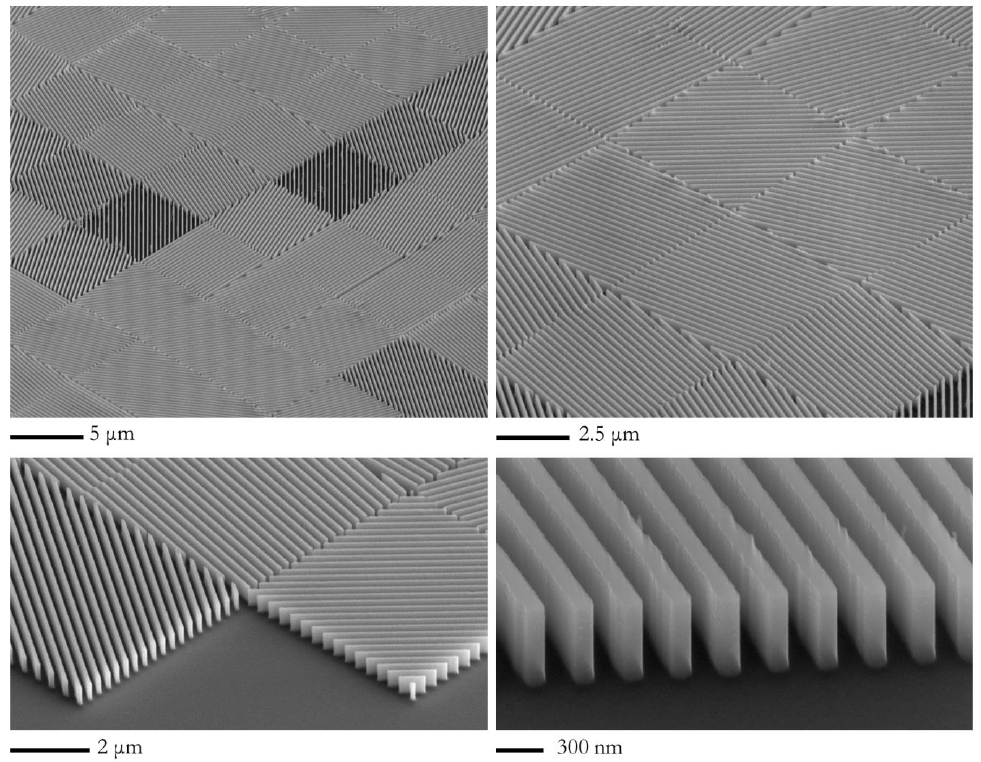
Figure 4. SEM inspections of the fabricated PBOE on a silicon substrate. Grating period Λ = 290 nm, duty cycle 0.5, thickness: 535 nm, pixel size: 6.125 μm, 16 rotation angles.